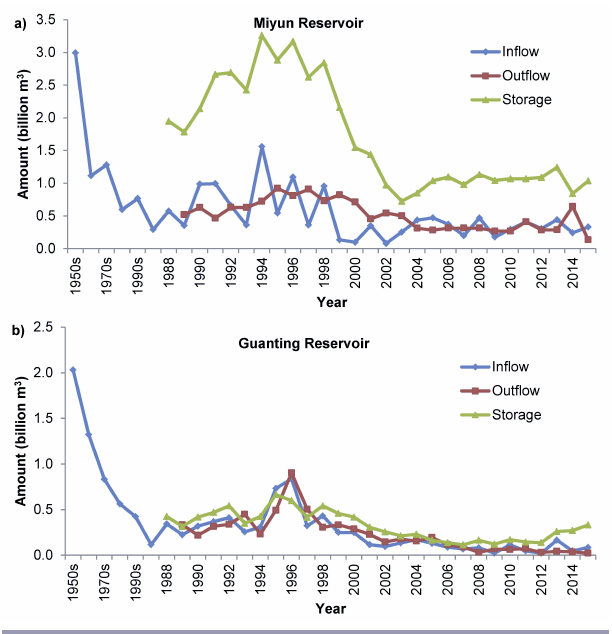
Fig. 4 . Estimates of annual water inflow, outflow, and storage in (a) Guanting Reservoir and (b) Miyun Reservoir. Data from Water Resource Administration Division of Beijing Water Resource Bureau and Jiao